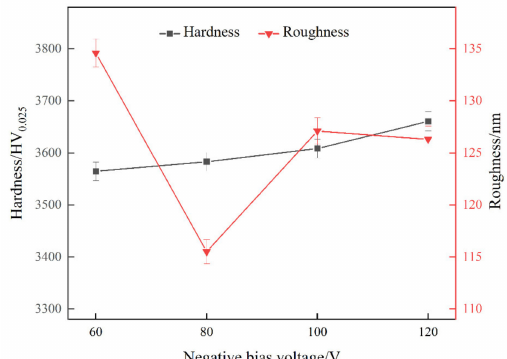
Figure 5. The trends of hardness and roughness of the coatings at different negative bias